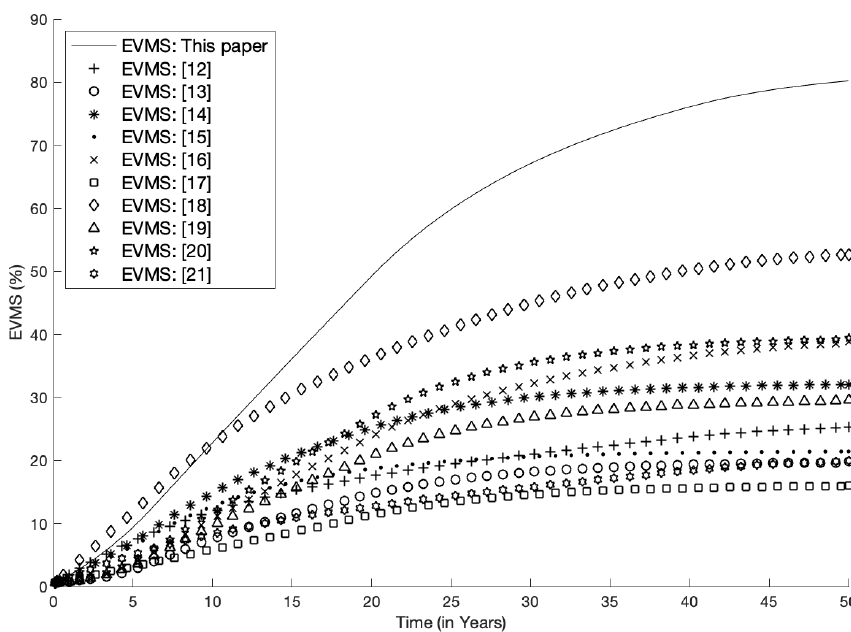
Figure 4. EV market share.